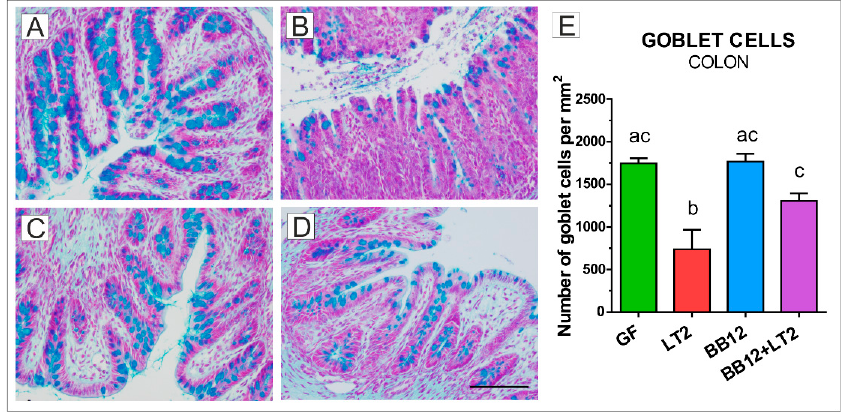
Figure 2. Goblet cells (blue color) in the colon of gnotobiotic piglets. Number of goblet cells per mm 2 in the colon of the one-week-old gnotobiotic piglets: germ-free (GF; ( A )), infected with S . Typhimurium LT2 for 24 h (LT2; ( B )), associated with B. animalis subsp. lactis BB-12 (BB12; ( C )), and associated with BB12 and infected with LT2 for 24 h (BB12 + LT2; ( D )) . Six samples from each group were analyzed, and statistical differences were calculated by a two-way ANOVA with Tukey’s mul- tiple comparison post hoc test. The values are presented as mean + SEM, and a p < 0.05 among groups is denoted by different letters above the columns ( E ). A scale bar ( D ) depicts 100 μ m. 2.4. TLR2, TLR4, TLR9, MyD88, TRIF, and RAGE mRNA in Ileum BB12 did not increase the expression of TLR2 mRNA in the ileum compared to the GF piglet control (Figure 3A). In contrast, both groups infected with S . Typhimurium (LT2 and BB12 + LT2) had significantly higher expression. The presence of BB12 (BB12 + LT2) did not significantly influence the TLR2 expression compared to S . Typhimurium infec- tion alone (LT2). Similar changes of mRNA expression were found in TLR4 (Figure 3B). An opposite trend was found in TLR9 mRNA expression (Figure 3C). TLR9 mRNA ex- pression was comparable in GF and BB12 groups but was downregulated by Salmonella infection. The prior association with BB12 (BB12 + LT2) did not ameliorate the LT2-in- ducted downregulation of TLR-9 expression. BB12 did not influence MyD88 mRNA ex- pression, but it was significantly upregulated by Salmonella (Figure 3D). The presence of BB12 enhanced this expression, so the expression in BB12 + LT2 group was significantly higher than in the LT2 group. In contrast, Salmonella downregulated the expression of TRIF mRNA (Figure 3E). Salmonella infection downregulated RAGE mRNA expression compared to GF, but this downregulation was only significant for LT2, and not for BB12 + LT2 (Figure 3F).